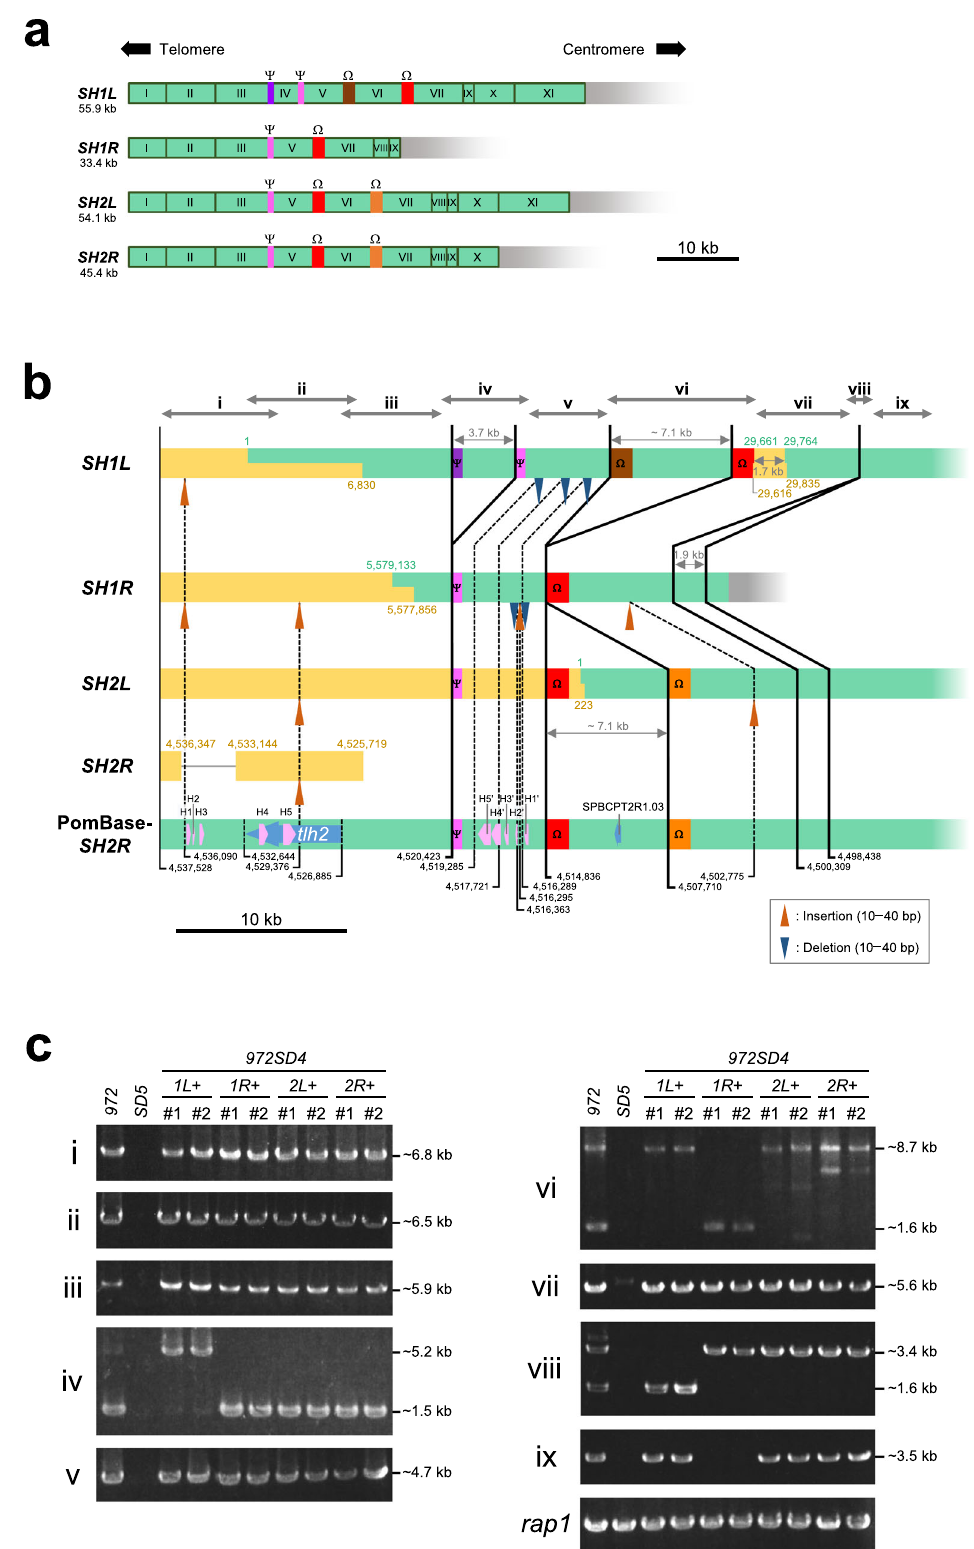
family, tlh3 and tlh4 , in SH1R and SH2L , respectively. Thus, genome of strain 972 contains four tlh genes in total (Fig. 8a and Supplementary Fig. 9). The descendent strains of 972 possess additional tlh ORF(s) in Ch3 (Supplementary Fig. 1), that may have transferred from their other chromosome ends or from mating partners. We also